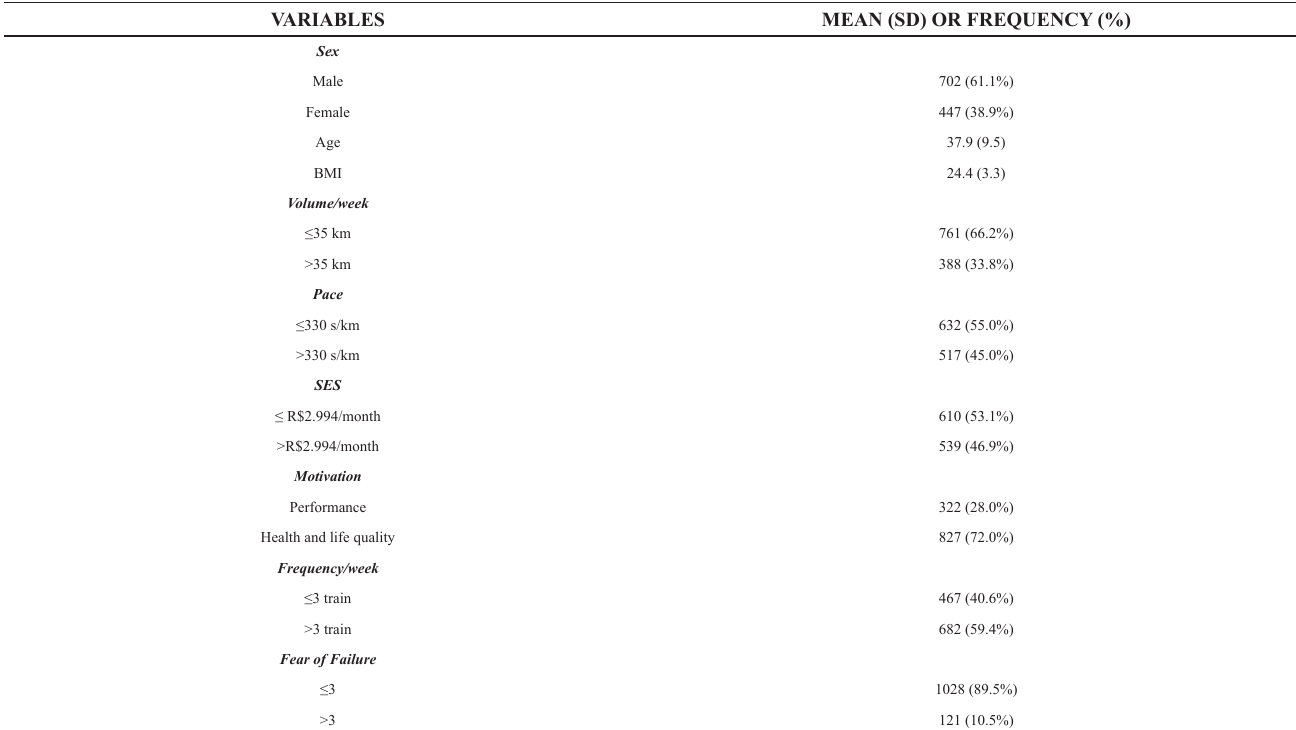
Table 1 - Descriptive information regarding biological and training variables, as well as the fear of failure of Brazilian runners